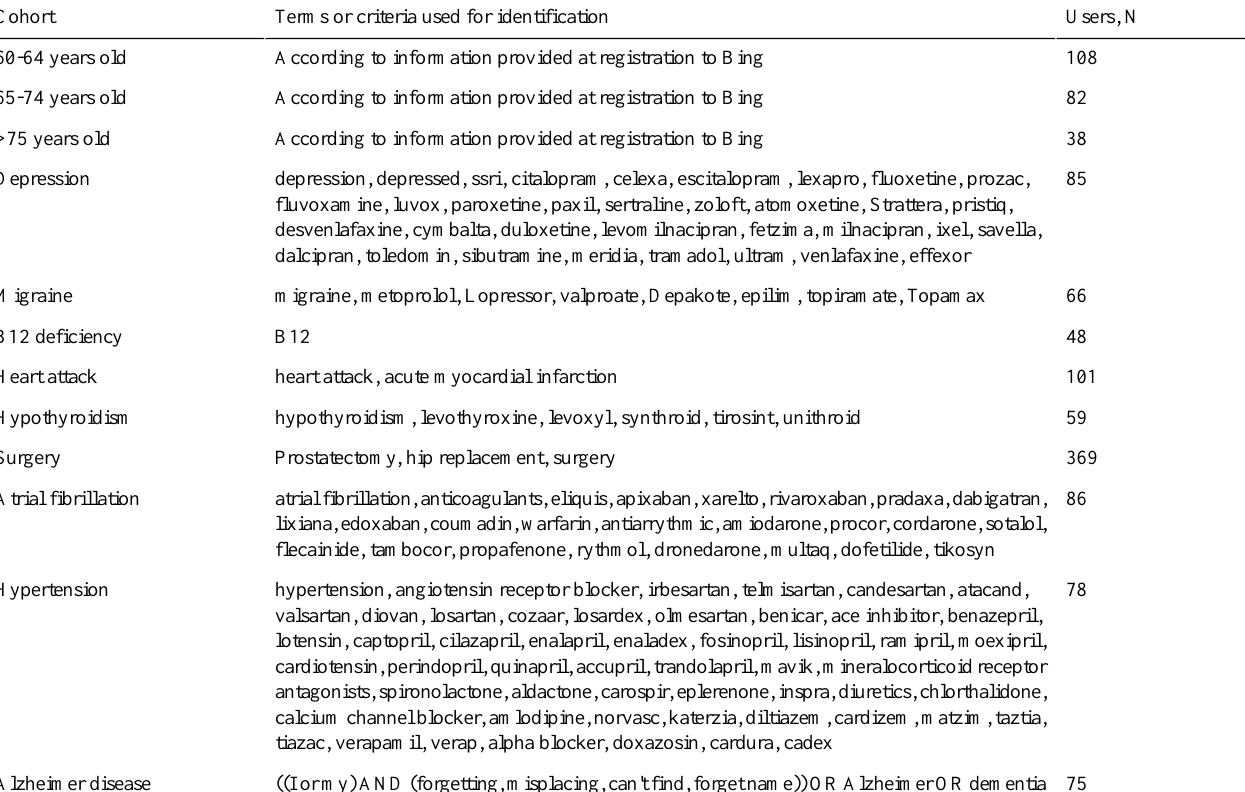
Table 1. Number of users in the control cohorts according to various conditions and the search terms used to identify the group.